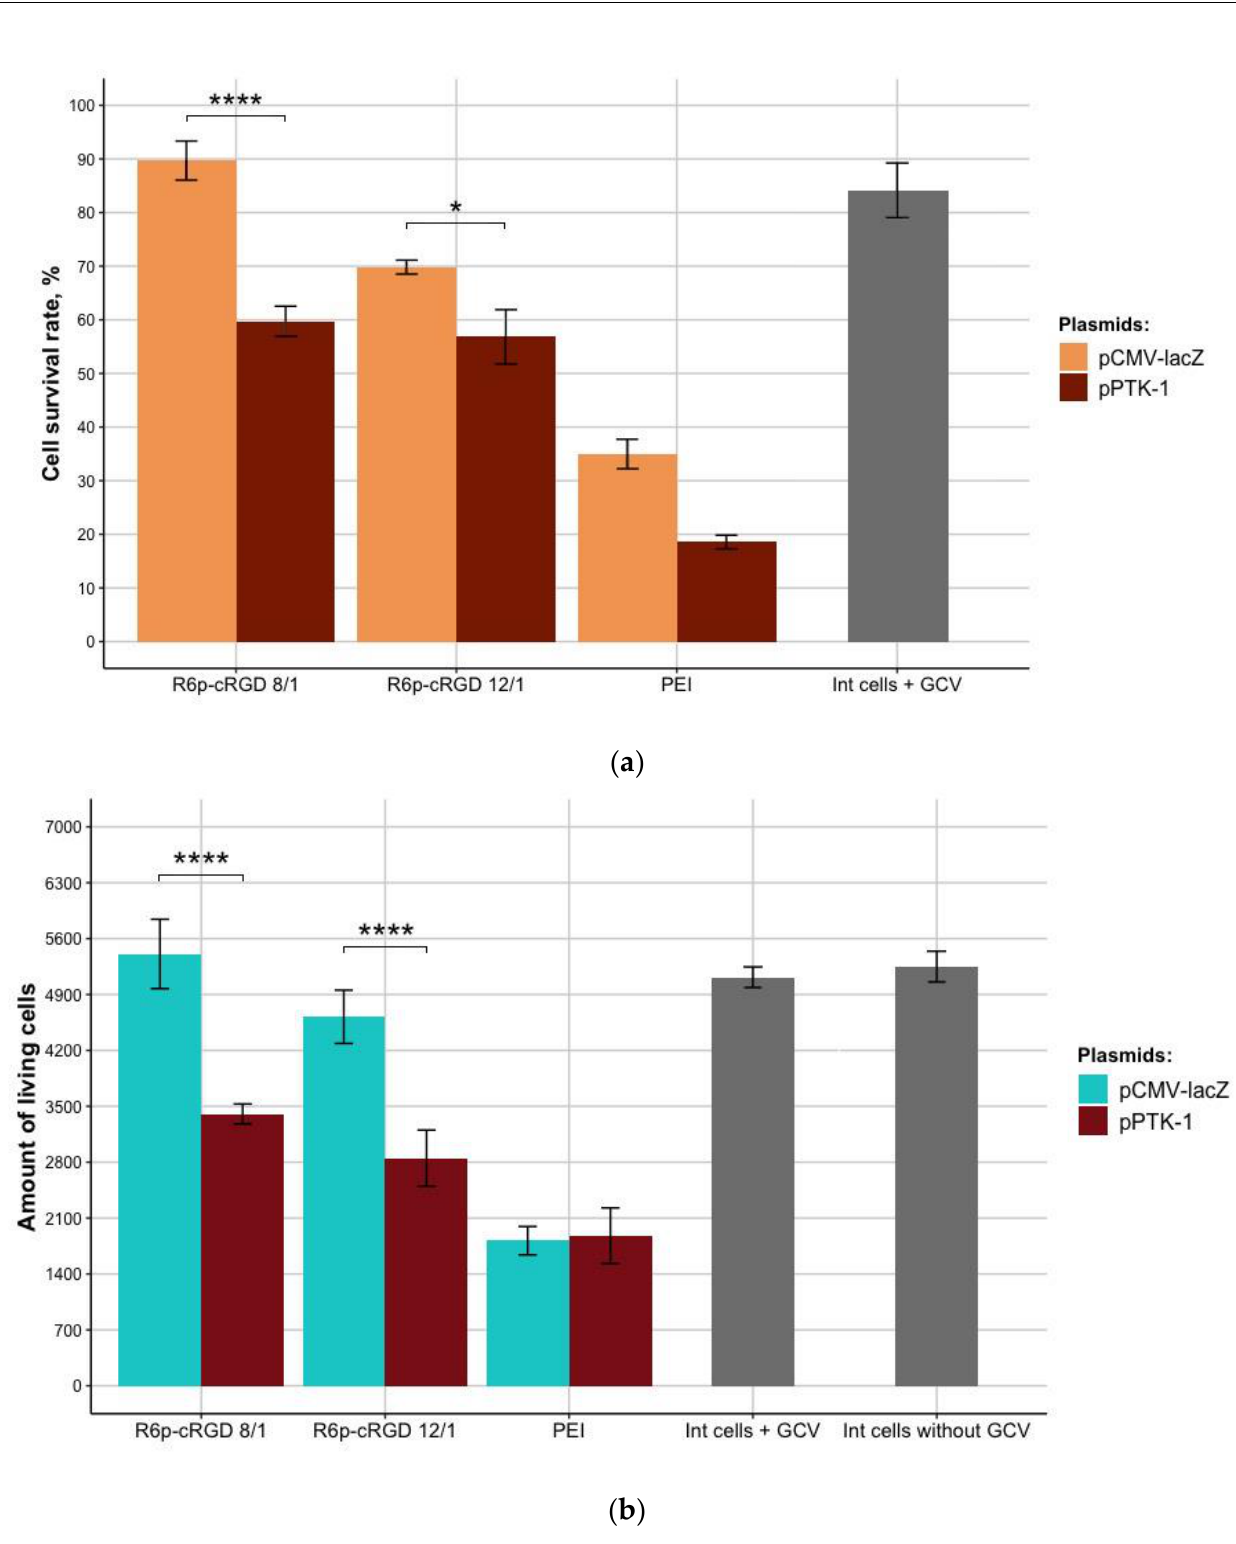
Figure 8. Relative number of UL cells (%) ( a ) accessed by Alamar Blue test and amount of living UL cells ( b )accessed by Trypan blue staining after suicidal gene therapy by transfection with pPTK-1-bearing polyplexes with MNPs and subsequent incubation with ganciclovir. Statistical significance was determined using One-way ANOVA with Sidak’s multiple comparisons test ( n = 9, * 0.05, **** 0.0001).